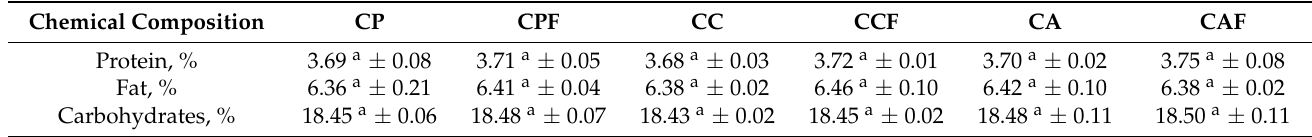
Table 1. Chemical composition of ice cream mixes samples after